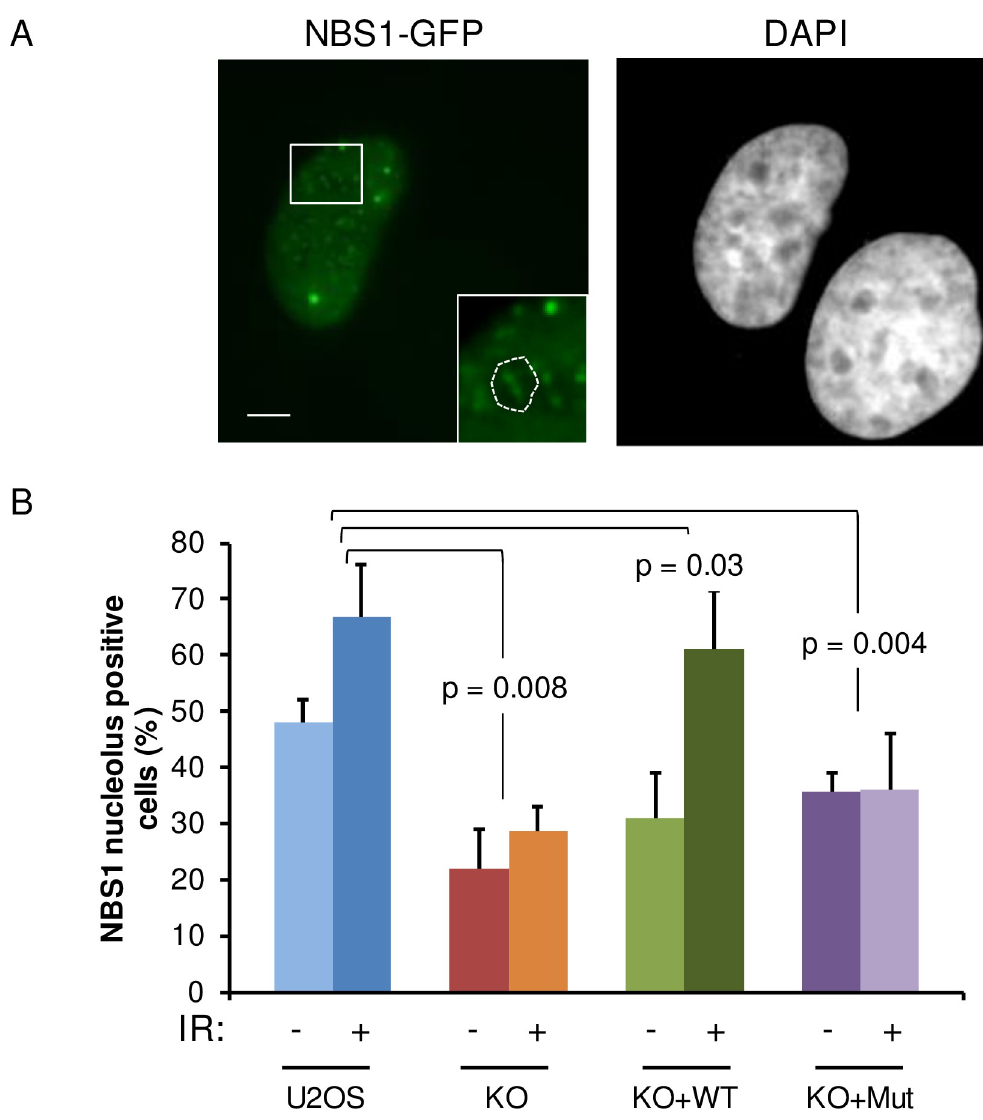
Fig 10. NBS1 localization in nucleoli after DNA damage is dependent on JMJD6. (A) Representative images of U2OS cells expressing NBS1-GFP after IR exposure (5 Gy). Insert showing the presence of NBS1 foci in nucleolus. Scale bar 5 μ m. (B) Quantification of the percentage of U2OS, JMJD6-KO and JMJD6-KO-complemented with wild type JMJD6 (KO +WT) and JMJD6-KO-complemented with an inactive form of JMJD6 (KO+Mut) cell lines expressing NBS1-GFP that exhibit NBS1 nucleolar foci without and after IR exposure. Results are the mean +/- standard deviation from three independent experiments. In each independent experiment more than 100 transfected cells were counted for each point. The p values of the difference to the U2OS cell line after IR are indicated (Student t